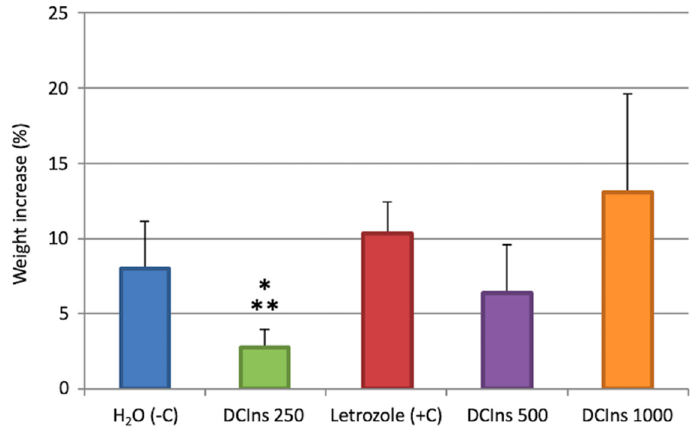
Figure 1. Increase in mouse weights during the 21-day treatment. Histograms represent percent weight increases (mean ± SD) depending on the molecules and doses received. One Way ANOVA, p < 0.005; *, p < 0.05 versus H 2 O and letrozole; **, p < 0.01 versus DCIns 1000.